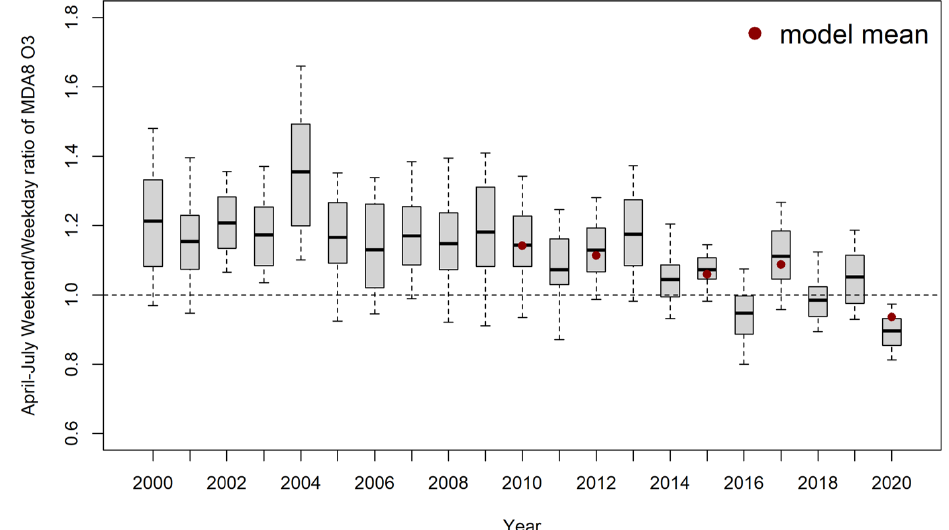
Figure 8. Box plots of the observed April–July WE / WD ratios of MDA8 O 3 at South Coast Air Basin monitoring sites. The solid lines in each box are the mean ratios of all of the sites, and the red dots are the modeled mean